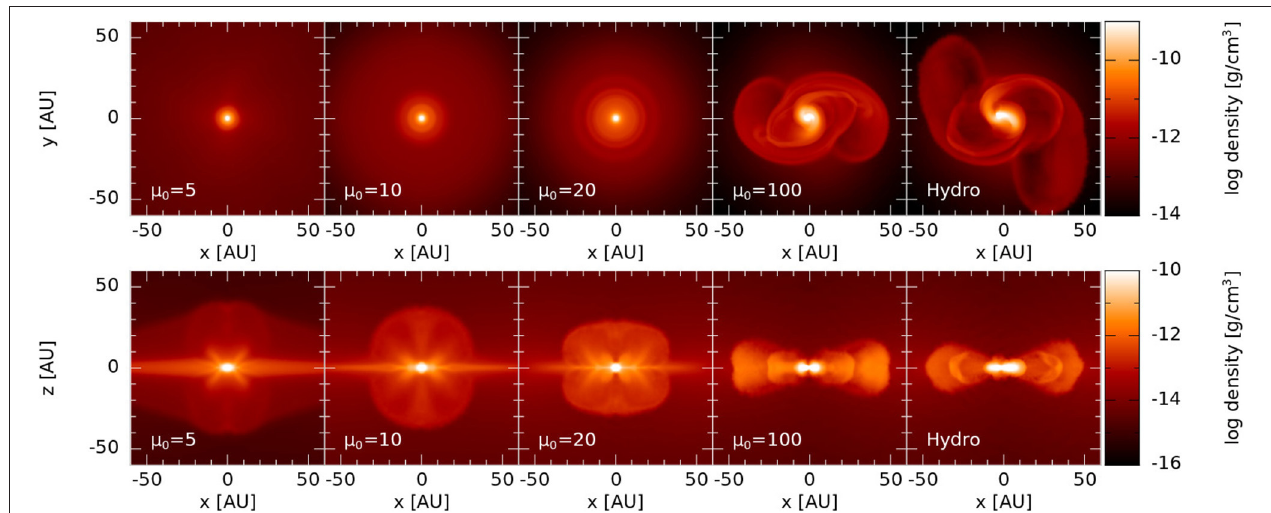
FIGURE 3 | The face-on (top row) and edge-on (bottom row) gas density in a slice through the centre of the first hydrostatic core for ideal MHD models of decreasing magnetic field strength (increasing µ 0 ; left to right) and a pure hydrodynamics model. Gravitationally unstable discs form for µ 0 > 20, whereas only pseudo-discs only form in the remaining models. This is inspired by Figure 4 of Bate et al. (2014), and was created for this publication using the data from Bate et al.